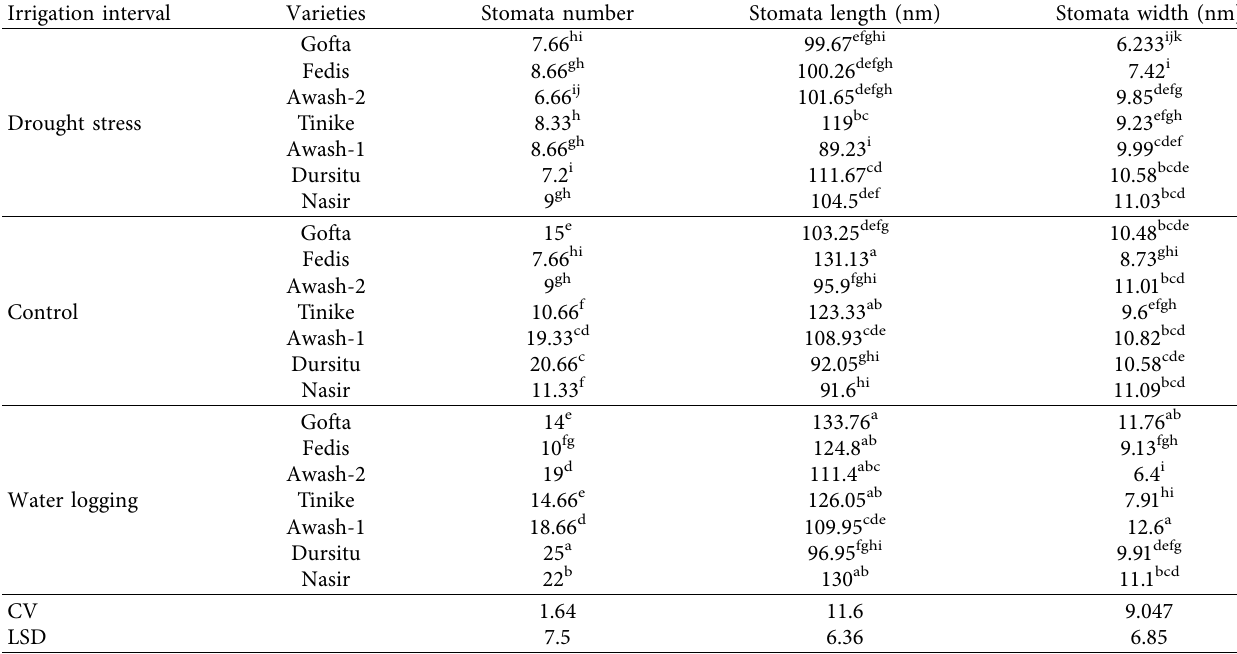
Within the column means with the same letter are not statistically signifcant.